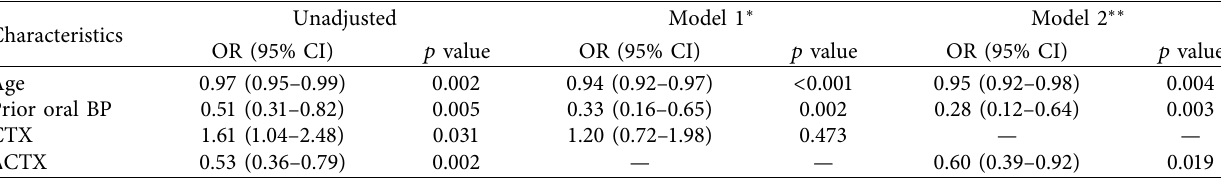
Table 3: Associations of clinical and demographic variables with acute-phase response following zoledronic acid infusion. Characteristics